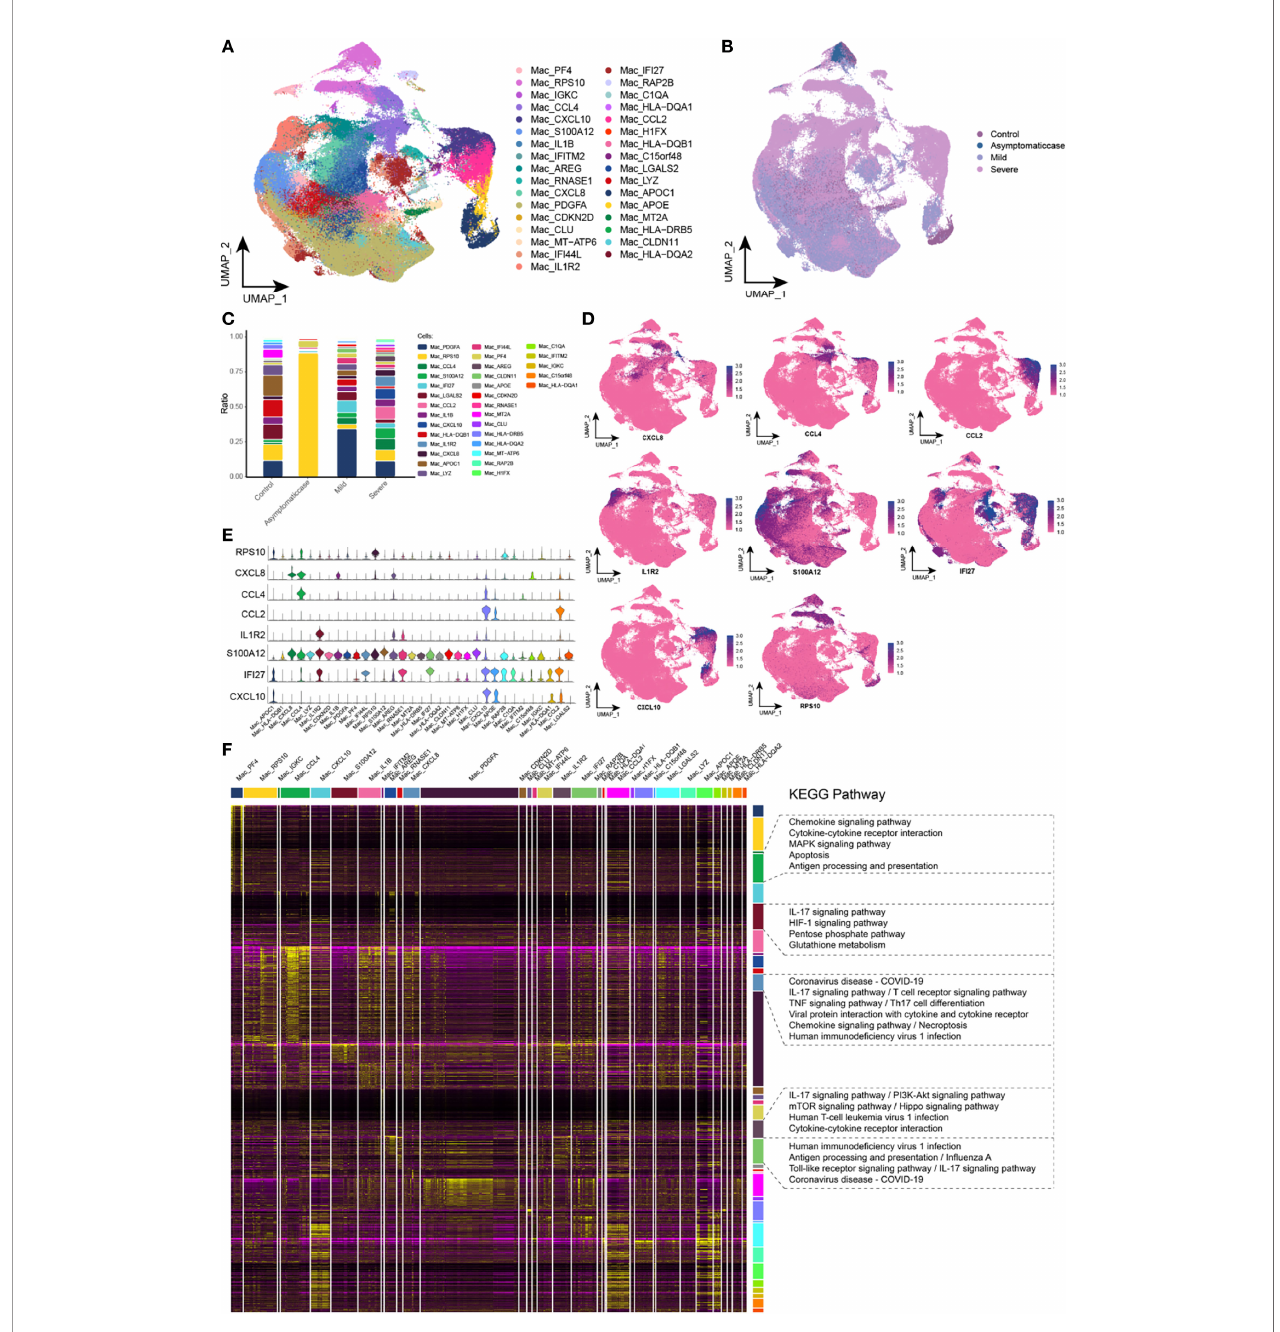
FIGURE 2 | Abnormal components of macrophage in patients with COVID-19. (A) Single-cell mapping of subsets of macrophages. (B) Single-cell mapping of macrophages mapped in the COVID-19 courses. (C) Components and changes of macrophage subsets in the COVID-19 courses. (D, E) Expression of marker genes in macrophage subsets. (F) Biological pathways involved in macrophage subsets with speci fi c changes. KEGG, Kyoto Encyclopedia of Genes and Genomes; Mac, macrophage; UMAP, Uniform Manifold Approximation and Projection for Dimension